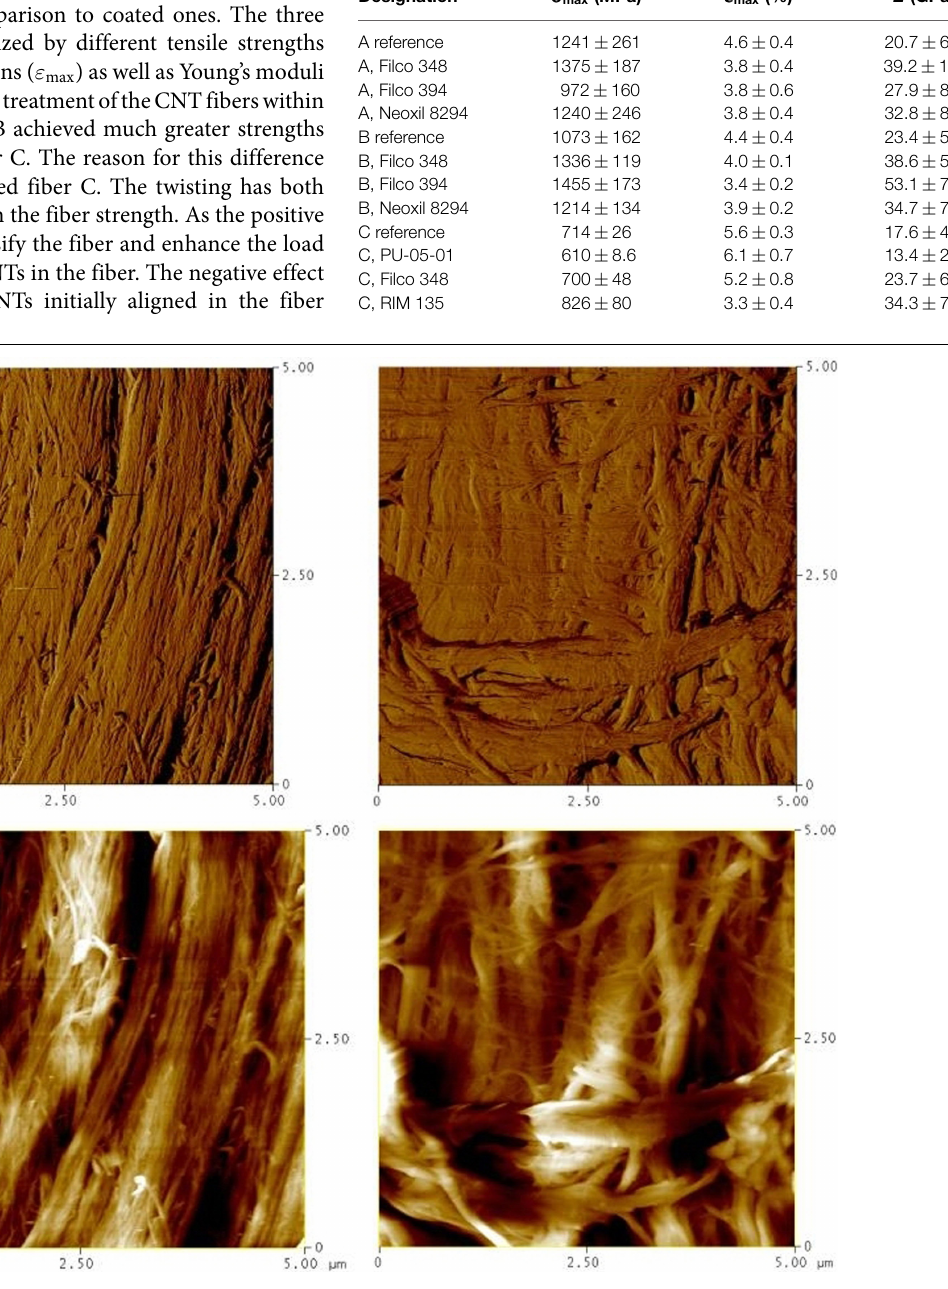
Frontiers in Materials |